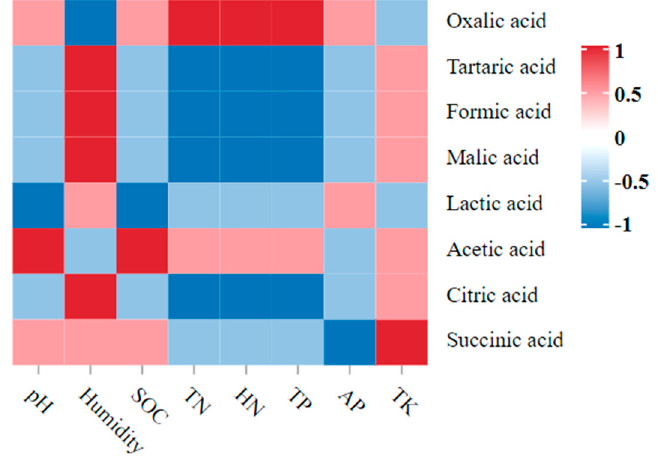
Figure 6. Dynamic correlation heatmap between the soil parameters and the LMWOAs. Note: Red indicates a positive correlation, and blue indicates a negative correlation.